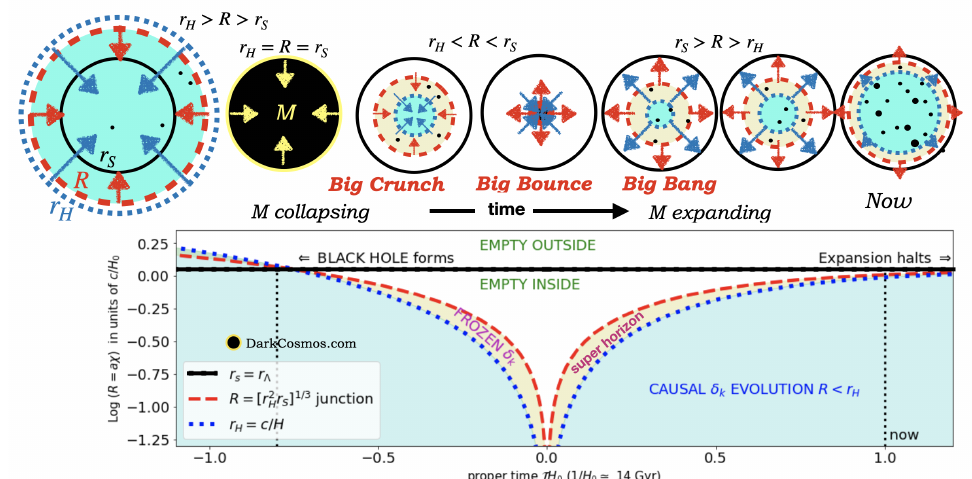
Figure 4. Physical coordinate radius R collapsing and expanding as a function of comoving time τ . A spherical cloud of radius R and mass M starts collapsing free-fall under its own gravity. When it reaches R = r S = 2 GM it becomes a BH (black sphere). The collapse proceeds inside the BH until it bounces into an expansion (the hot Big Bang). The BH Event Horizon r S behaves like a cosmological constant with Λ = 3/ r 2 so that the expansion freezes before it reaches back to r S . Blue shading S ( R < r H ) indicates causal evolution of radial perturbations. White is approximated as empty space. Super horizon structures in-between R and r H (yellow shading) are “frozen” and they seed structure formation as they re-enter r H . Contrary to Inflation, the super horizon spectrum of perturbations in the BHU has a cut-off given by R